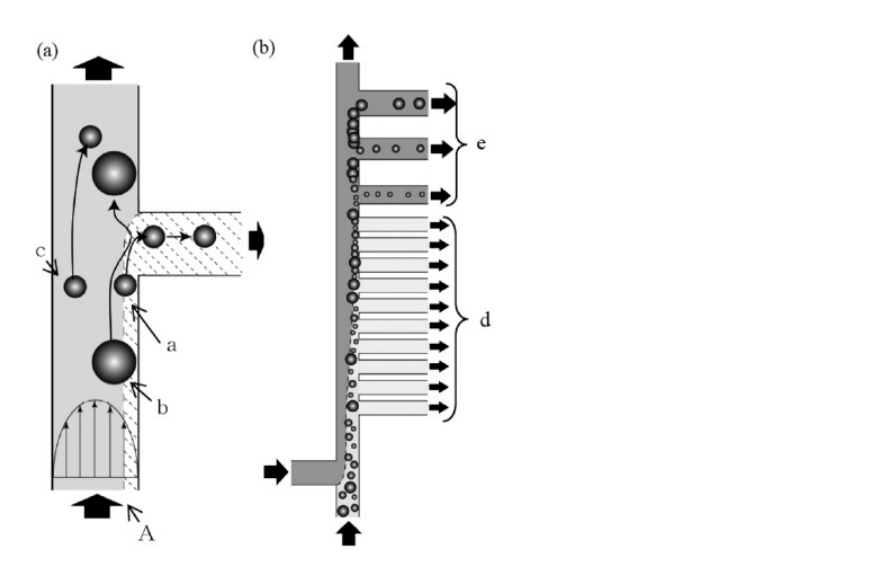
Figure 6. Principle of particle classification and concentration: ( a ) particle behavior at a branch point; ( b ) schematic diagram of particle classification and concentration in microchannel having multiple branch points and side channels. The figure has been reproduced with permission from John Wiley and Sons [161]. “a” represents a particle can enter the side channel, “b” and “c” represent particles that cannot enter the side channel; “d” represents the area where particles larger than a certain size cannot pass through; “e” represents the downstream area where particles are removed from the main stream in ascending order of size. A is the borderline and when a particle flows in the right region of the borderline, such a particle can enter the side channel. Table 1. Public-health-related passive approaches for microfluidic